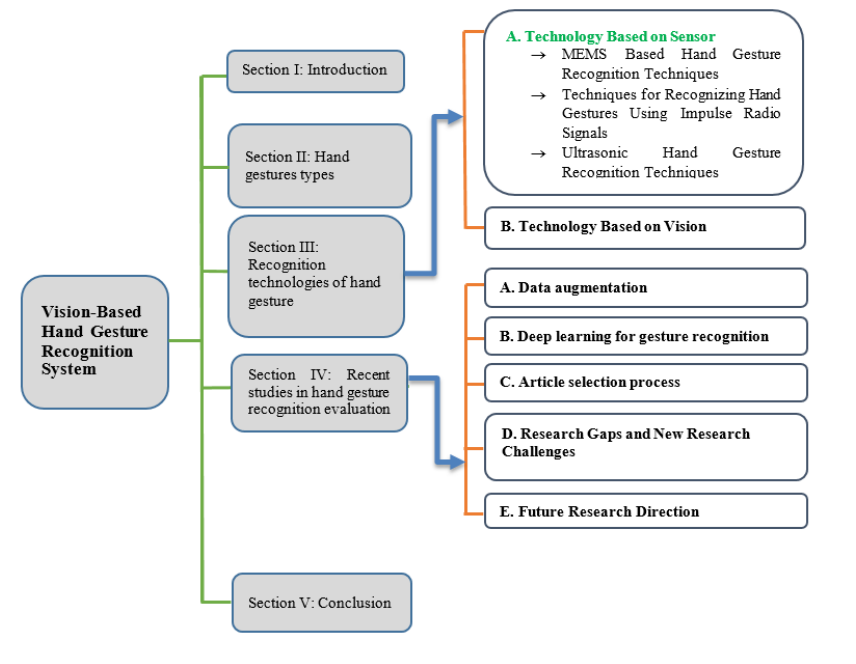
Figure 4. Five class graphical